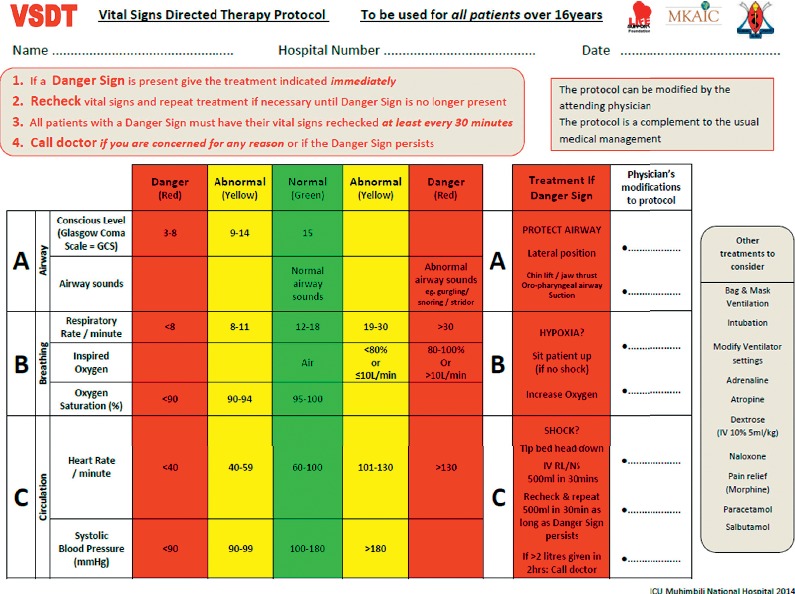
The Vital Signs Directed Therapy Protocol. The protocol provides criteria for the classification of vital signs as either normal (green), abnormal (yellow), or danger sign (red) and prompts treatments for danger signs. It was introduced in the main intensive care unit in Muhimbili National Hospital in March 2014.